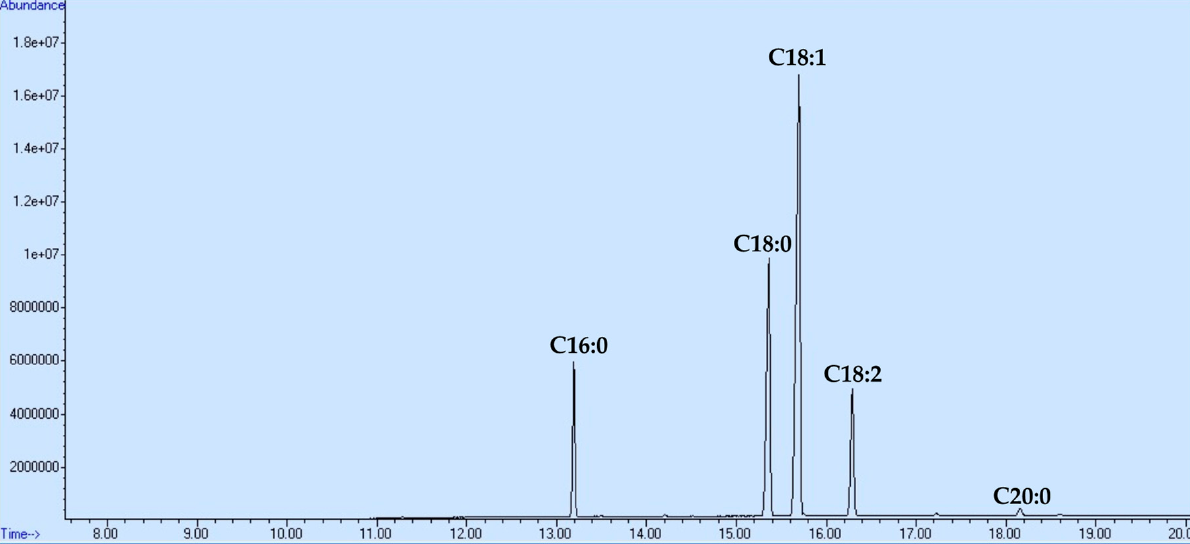
Figure 2. GC analysis of chromatogram of OMSS extracted by AEE.